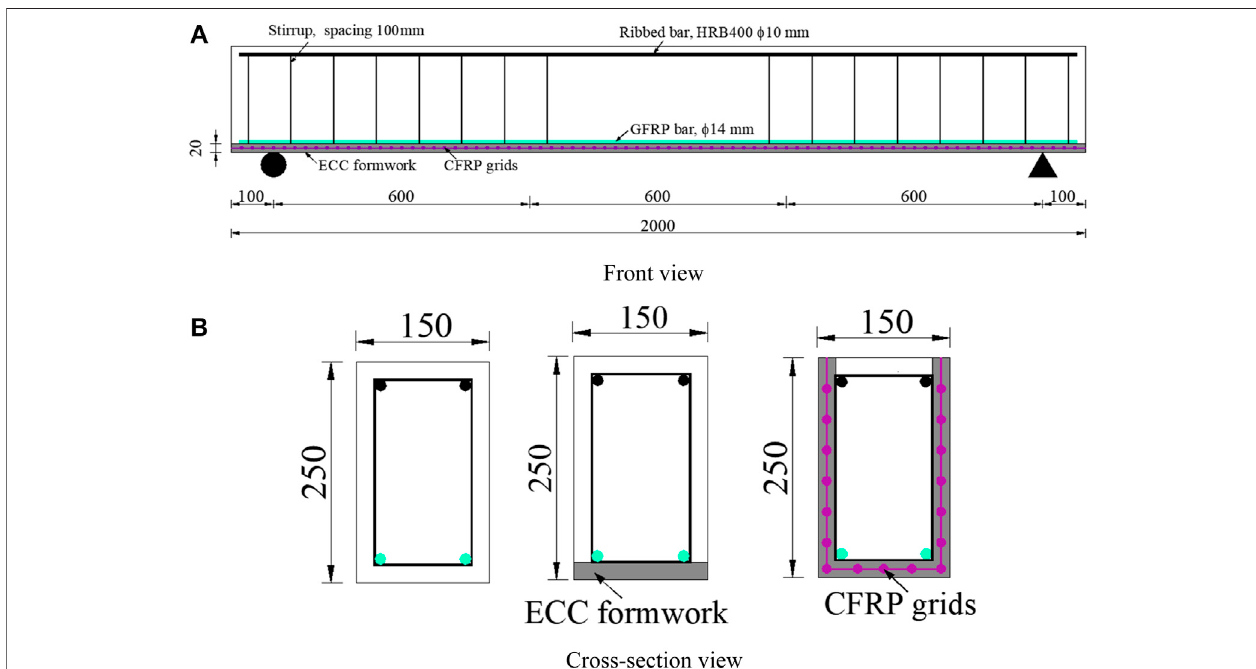
FIGURE 1 | Schematic diagram of a composite beam.